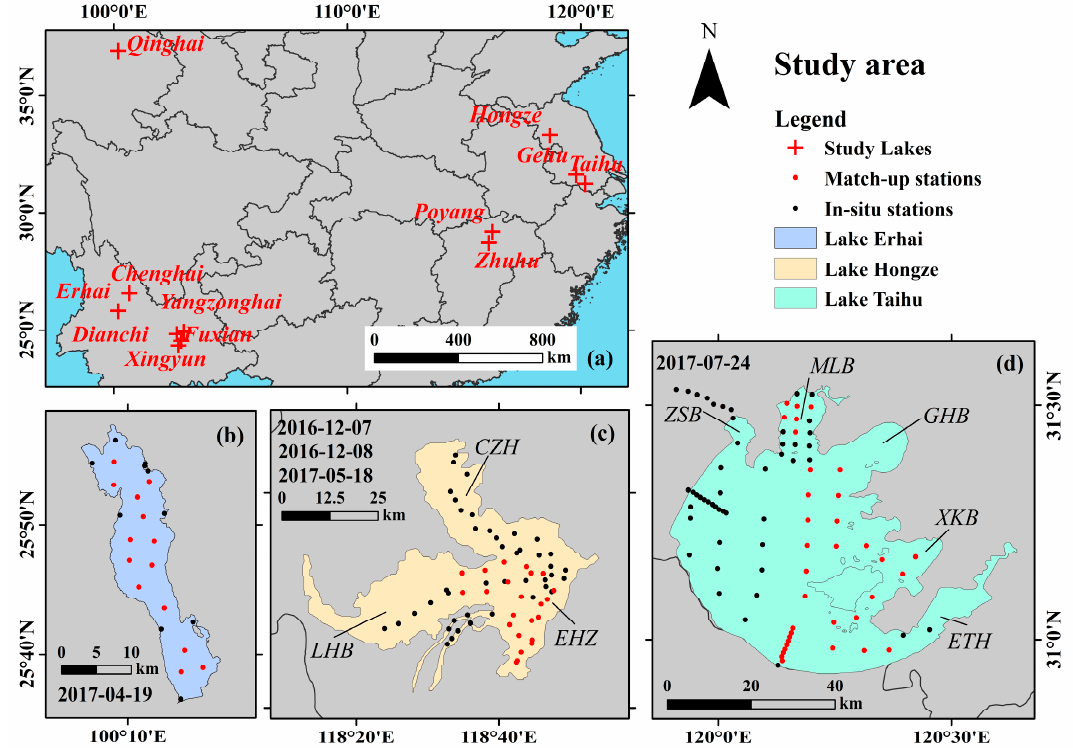
Figure 1. The 12 lakes in the plateau and the plains are annotated using red crosses in ( a ) Lake Qinghai, Lake Erhai, Lake Chenghai, Lake Dianchi, Lake Yangzonghai, Lake Fuxian, and Lake Xingyun in the plateaus; Lake Poyang, Lake Zhuhu, Lake Hongze, Lake Gehu, and Lake Taihu in the plains. Moreover, three sets of satellite-synchronous in situ stations are presented using red dots, including ( b ) Lake Erhai ( N = 14); ( c ) Lake Hongze ( N = 23), where CZH (Chengzihu), LHB (Lihe Bay) and EHZ (Eastern part of Lake Hongze) are the three regions of Lake Hongze; ( d ) Lake Taihu ( N = 35), where ZSB (Zhushan Bay), MLB (Meiliang Bay), GHB (Gonghu Bay), XKB (Xukou Bay), and ETH (the eastern part of Lake Taihu) are the five regions of Lake Taihu. Dots in black are stations out of the 6 h time window referring to the image time.